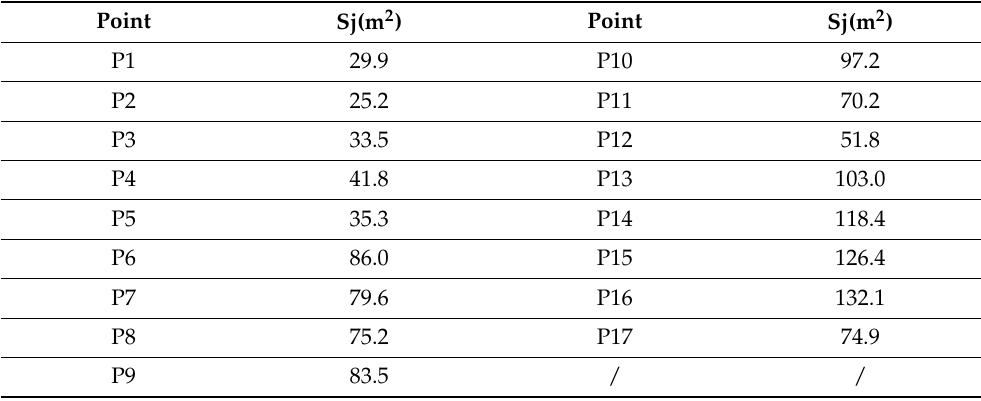
Figure 5. Layout of the measuring points and definition of the coordinate system (unit: m): ( a ) arrangement of the wave height measuring points; ( b ) arrangement of the pressure measuring points. Table 2. Representative area of pressure measuring points.